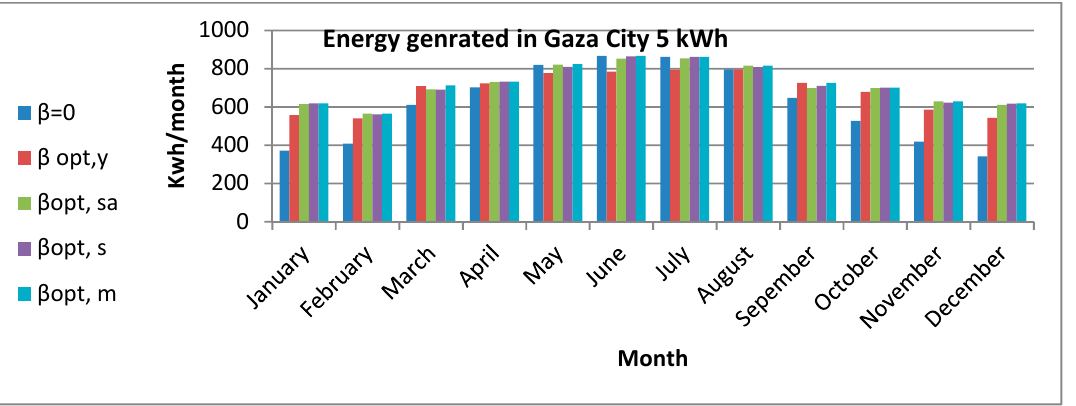
Figure 12. Monthly energy generated in Gaza city by a 5 kWh system .